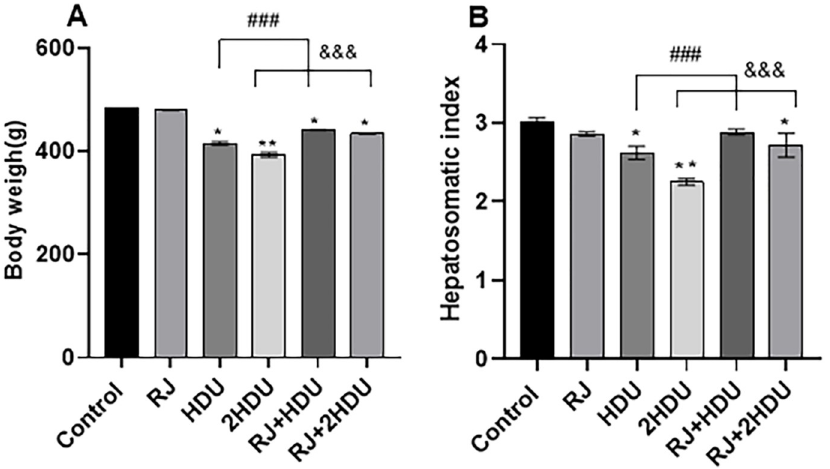
Fig 2. Effects of oral royal jelly (RJ; 100 mg/kg bwt) administration on body weight (A) and hepatosomatic index (B) in rats treated with hydroxyurea (HDU; 225 or 450 mg/kg bwt) for 60 days. Data are presented as the mean ± SEM. Compared to the control, significance at (p < 0.001) ��� (ANOVA with Dunnett’s multiple comparison test). Compared to HDU treated groups using Unpaired t-test, significance at p < 0.01 ## and p < 0.001 &&& for HDU and 2HDU groups, respectively).